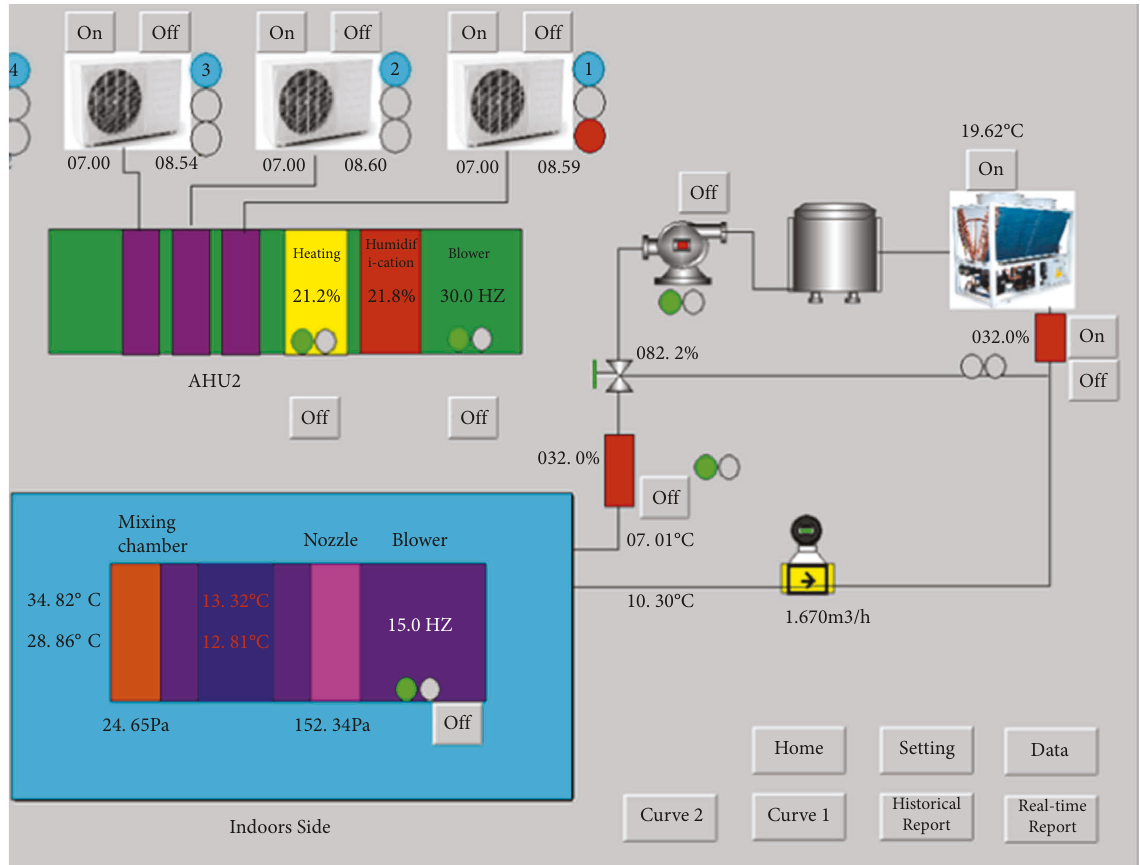
Figure 5: Control principle of the experimental system.